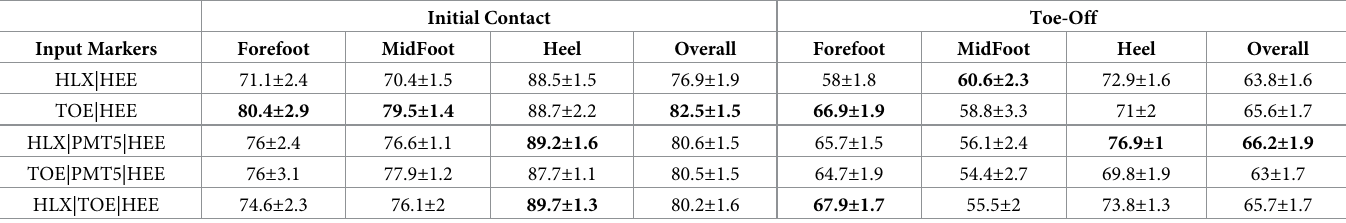
Table 4. Percentage of predicted events that correspond to a true event within ± 16ms.